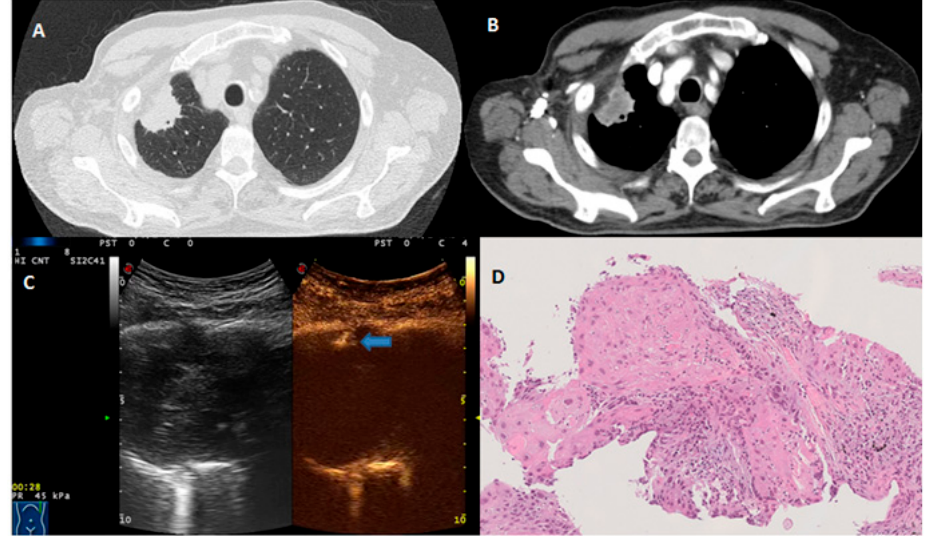
Figure 2. ( A ) Axial chest CT scan (lung window) showing a subpleural pulmonary lesion in the upper lobe of the right lung. ( B ) Axial contrast-enhanced CT scan (mediastinal window) showing inner necrosis in the same subpleural pulmonary lesion. ( C ) CEUS scan with SonoVue showing the arrival time of the ultrasound contrast agent (blue arrow) at 28 s. ( D ) Histopathological examination showing multiple keratinizing foci (hematoxylin and eosin ×10). The final diagnosis was squamous cell lung carcinoma.